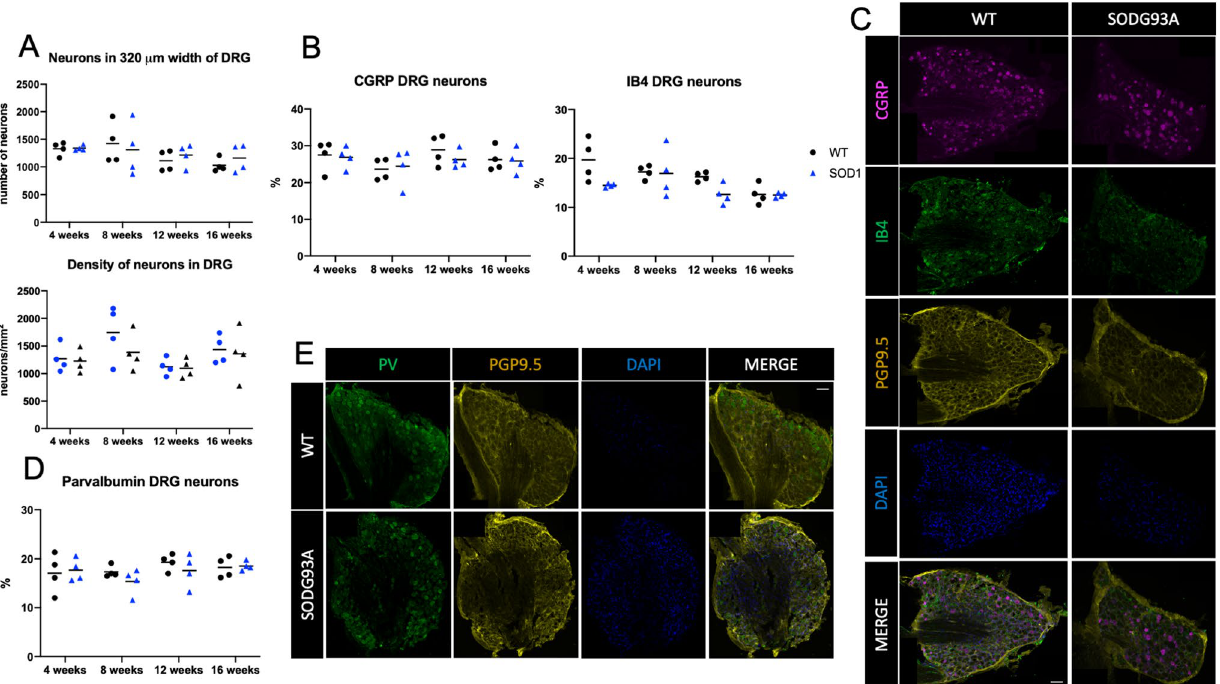
Figure 3. Neuronal bodies are preserved in the DRG of the SOD1 G93A mice. ( A ) Total number of neurons in 320 μm width of the DRG (counted in 6 sections of the DRG) (top plot), and density of neurons per mm 2 in the DRG (bottom plot). There were no differences in the overall number nor in the density of DRG neurons. PGP9.5 labeling was used for the overall neuron count. ( B ) Percentage of CGRP and IB4 sensory populations in the DRG of SOD1 G93a mice compared to the WT. There were no differences between groups and overtime. ( C ) Representative images of DRG of WT and SOD1 G93A mice showing CGRP and IB4 sensory populations. Scale bar: 100 μm. ( D ) Percentage of PV+ DRG sensory populations of SOD1 G93A mice compared to the WT. There were no differences between groups and overtime. ( E ) Representative images of DRG of WT and SOD1 G93A mice showing PV sensory neurons. Scale bar: 100 μm. Immunofluorescence colors have been adapted to the color-blind. 4 mice WT (black dots) and 4 mice SOD1 G93A (blue triangles) were used in each group. Differences were assessed by two-way ANOVA with post hoc